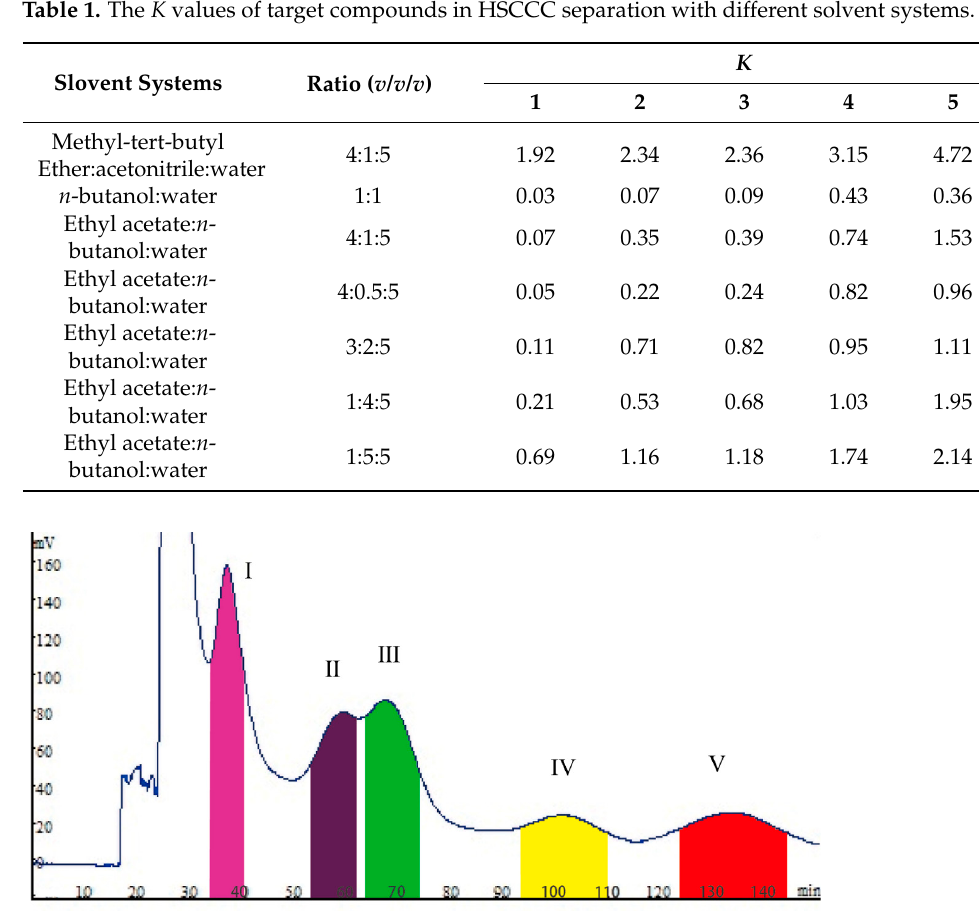
Figure 3. The HSCCC separation chromatogram of fractions I–V. HSCCC conditions: solvent system: ethyl acetate: n -butanol:water (1:4:5, v/v/v ); stationary phase: UP; mobile phase: LP; rotating speed: 800 rpm; flow rate: 2.0 mL/min; separation temperature: 25 °C; detection wavelength: 220 nm; sample solution: extract 80 mg + UP 10 mL + MP 10 mL.